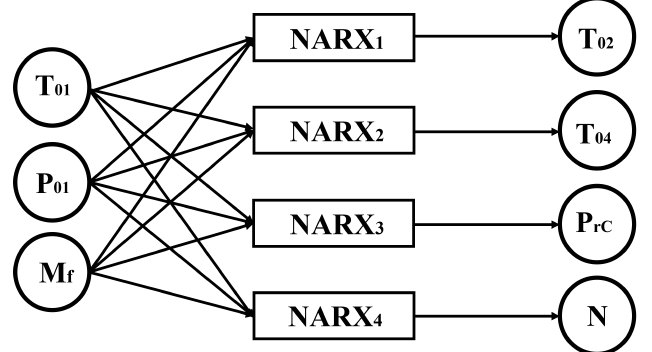
Figure 12. A schematic of NARX structure for gas turbine model [60].